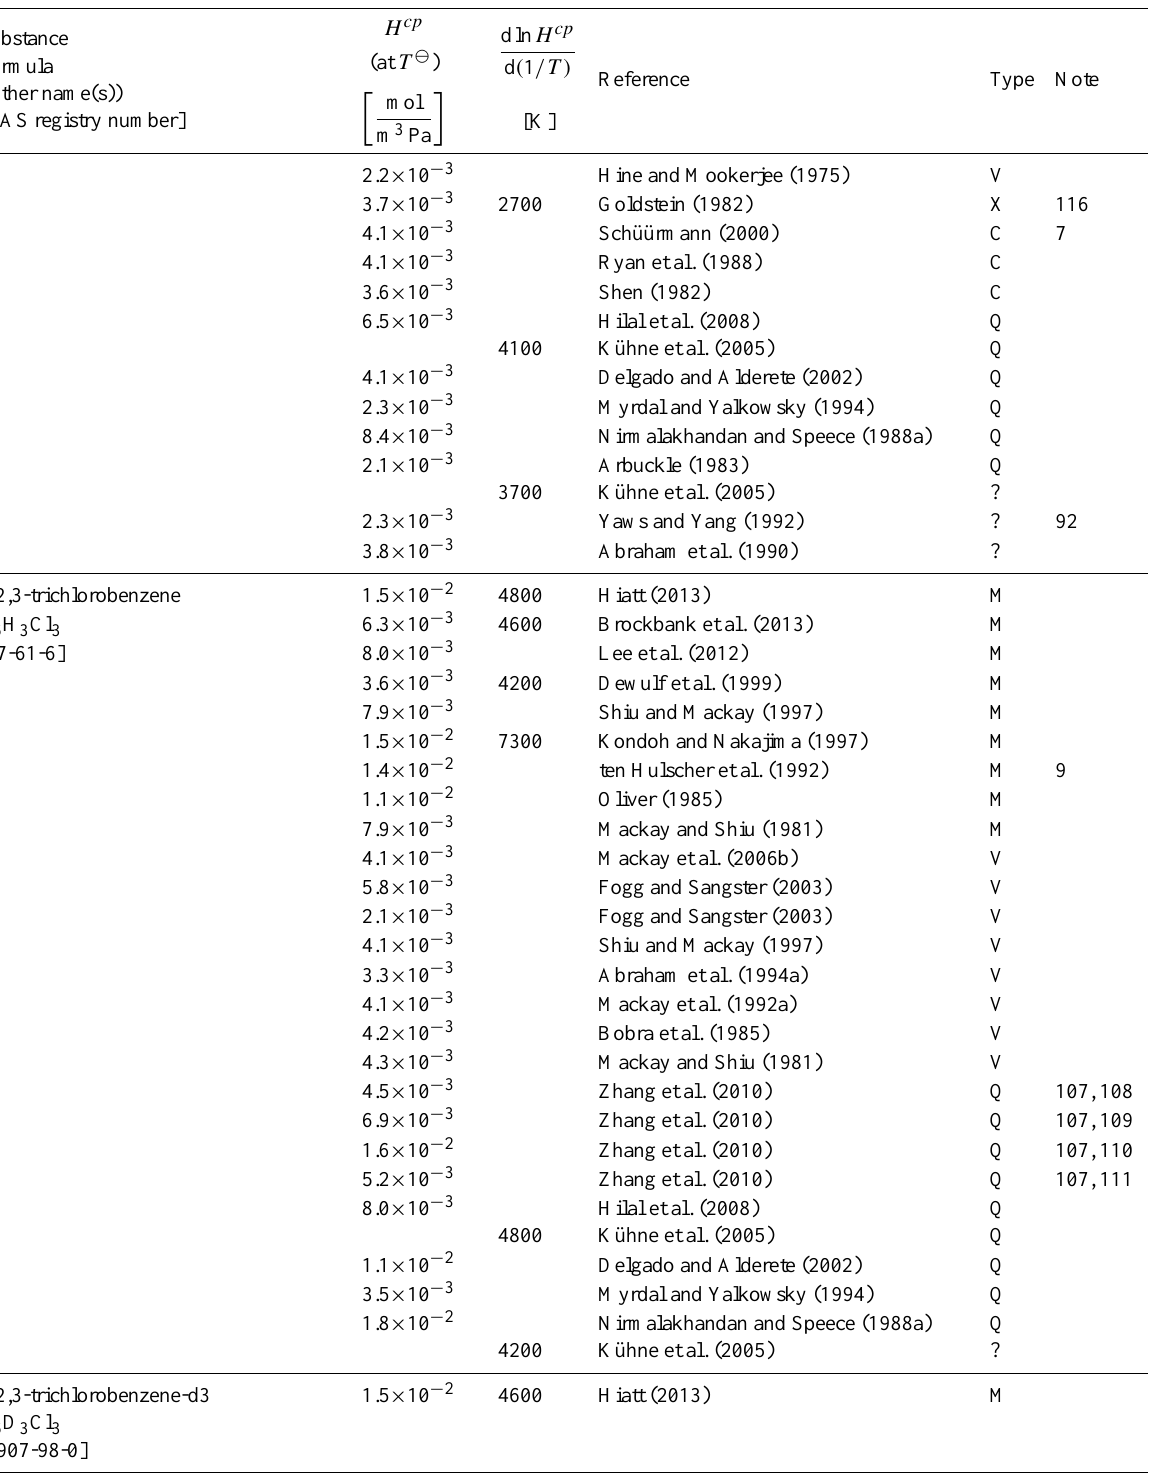
Table 6: Henry’s law constants for water as solvent